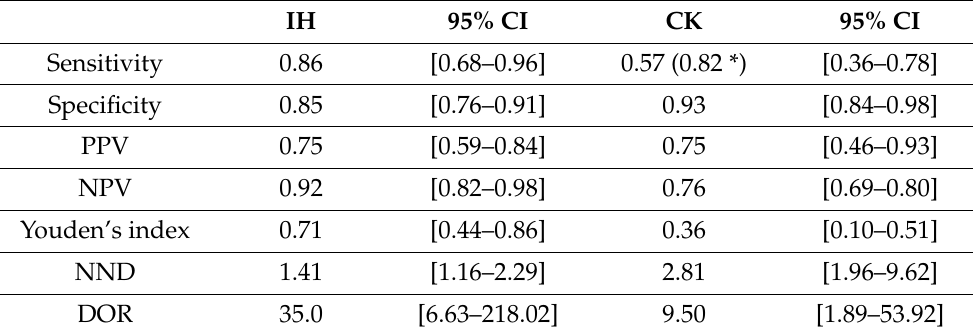
Table 4. Diagnostic indices of the IH and CK-PCR assays on ( n = 62) hair samples compared to conventional methods as the diagnostic gold standard.